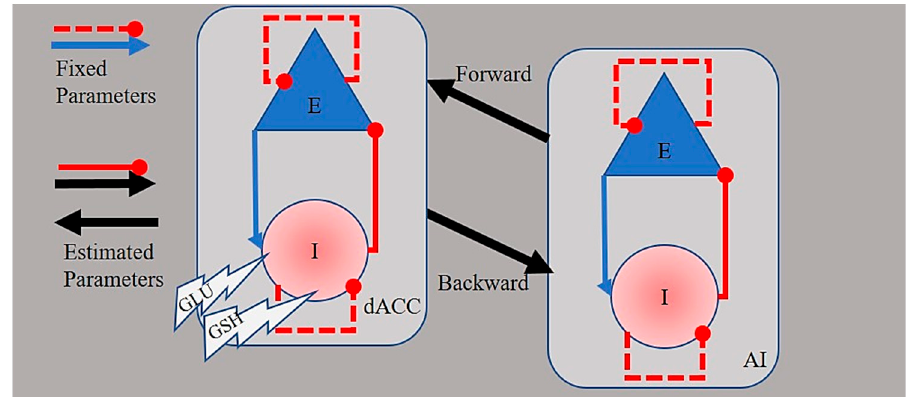
Figure 2. Circuit model of the dACC–AI network. In a two-state dynamic causal model, both inhibitory (I) and excitatory (E) neuronal populations comprise self-inhibitory connections (dashed red lines with oval arrows) which are fixed parameters. Excitatory intrinsic connections (i.e., from E neurons to I neurons, EI, solid lines with blue arrows) activate I neurons, and are fixed parameters. Inhibitory intrinsic (GABAergic) connections (i.e., from I neurons to E neurons, IE, solid lines with oval red arrows) inhibit E neurons and are free parameters. Extrinsic forward and backward (glutamatergic) connections (black arrows) are also free parameters.